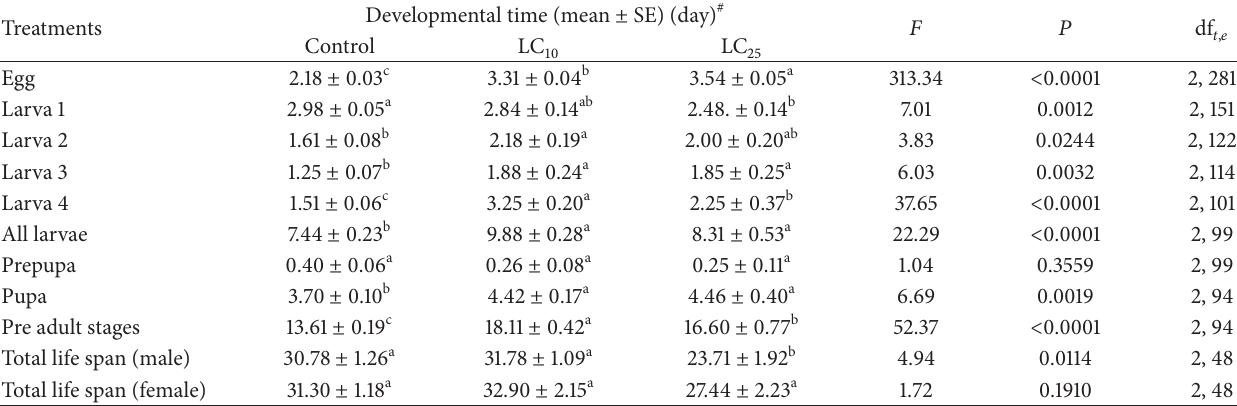
Table 3: The effects of pyriproxyfen on the developmental period of 3rd instar larvae of P. xylostella in two subsequent generations. Treatments